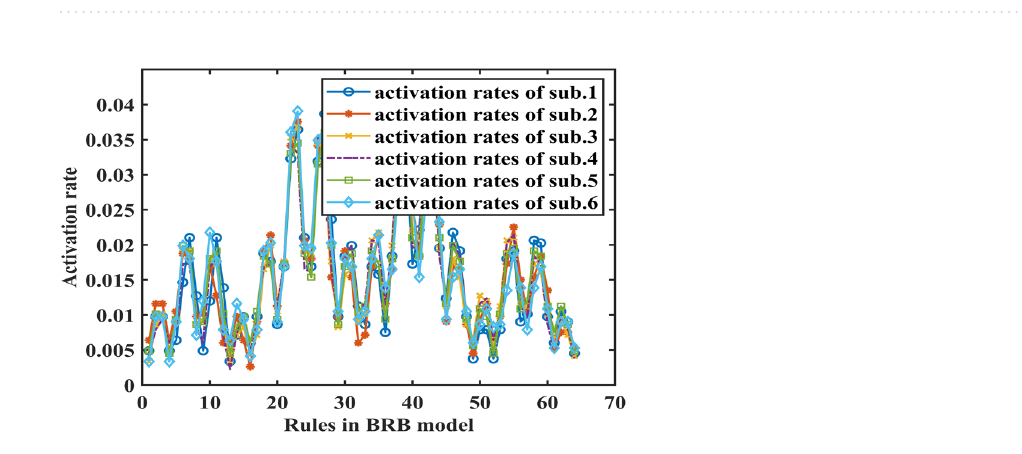
Figure 9. The activation rates of 64 rules generated by all samples.